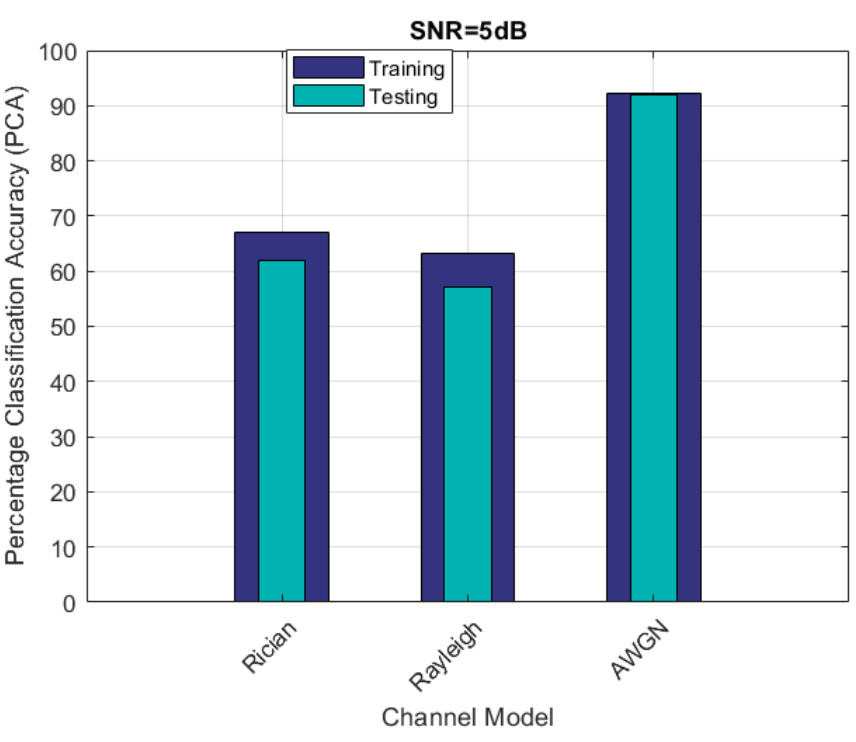
Figure 10. VB-DCNN Performance Analysis on Fading Channels (SNR = 5 dB).